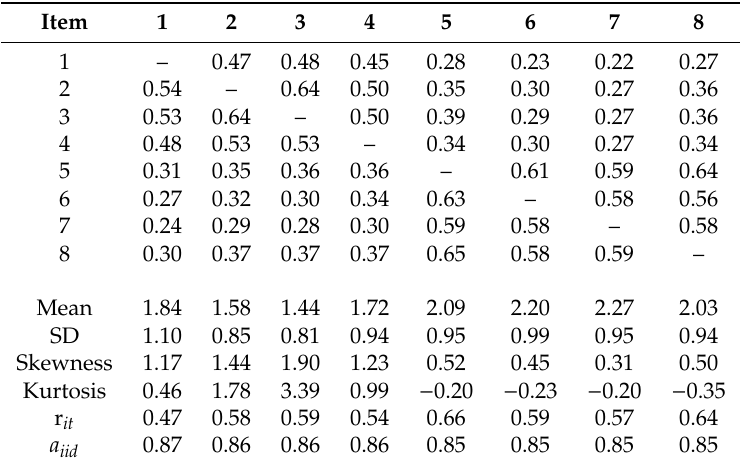
Table 3. Descriptive statistics and items correlations for the CRIT items.